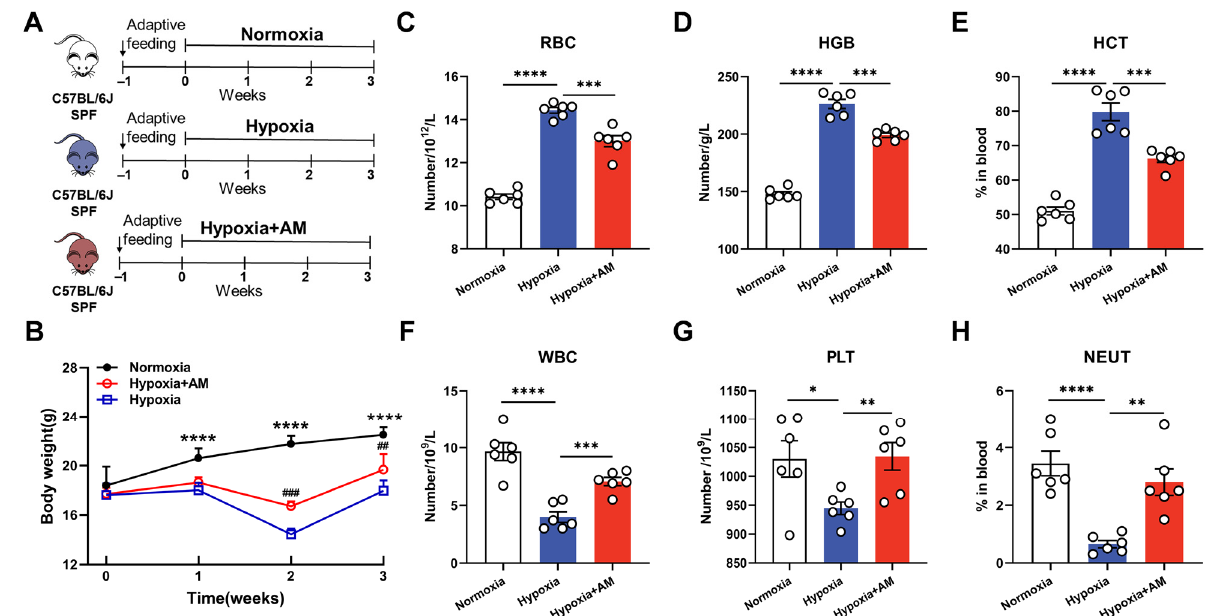
Figure 8. AM relieved hematological abnormalities in HAPC mice. ( A ) The design of animal experiments. Animals were kept in a low-pressure hypoxic chamber for 3 weeks to establish a HAPC model and the Normoxic animals as controls. One group of model animals was supplemented with AM by gavage to assess its effect on HAPC. ( B ) The changes of body weight in mice after 3 weeks of different treatments. n = 6. **** p < 0.0001; Normoxia vs. Hypoxia. ## p < 0.01, ### p < 0.001; Hypoxia + AM vs. Hypoxia. ( C – H ) The analysis of peripheral blood from mice in different groups. RBC, red blood cell; HGB, hemoglobin concentration; HCT, hematocrit; WBC, white blood cells; PLT, platelets; NEUT, neutrophils. n = 6. * p < 0.05, ** p < 0.01, *** p < 0.001, **** p < 0.0001. Compared with the Hypoxic group.